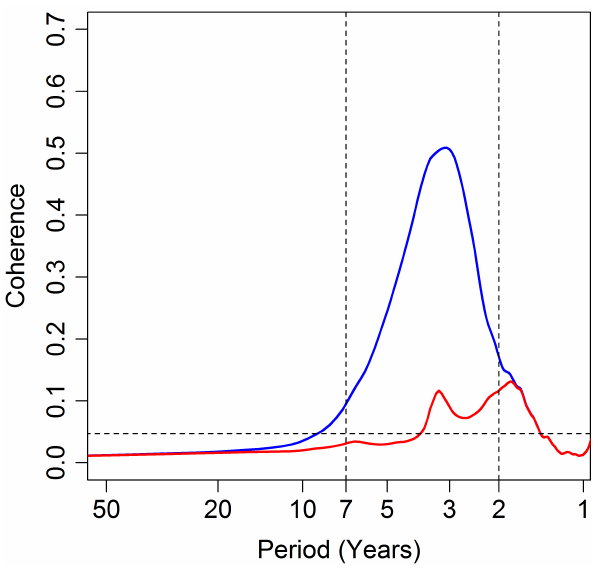
Fig. 2. Coherence of MEI to unsmoothed AMOI (blue), and MEI to AMOI reconstructed from all AMOI EOFs minus AMOI(ENSO) EOFs. The horizontal axis is the spectral period in years. Vertical dashed lines mark ENSO band frequencies, the horizontal dashed line quantifies the threshold to reject the null hypothesis of random coherence at the 95% confidence level (Thompson,